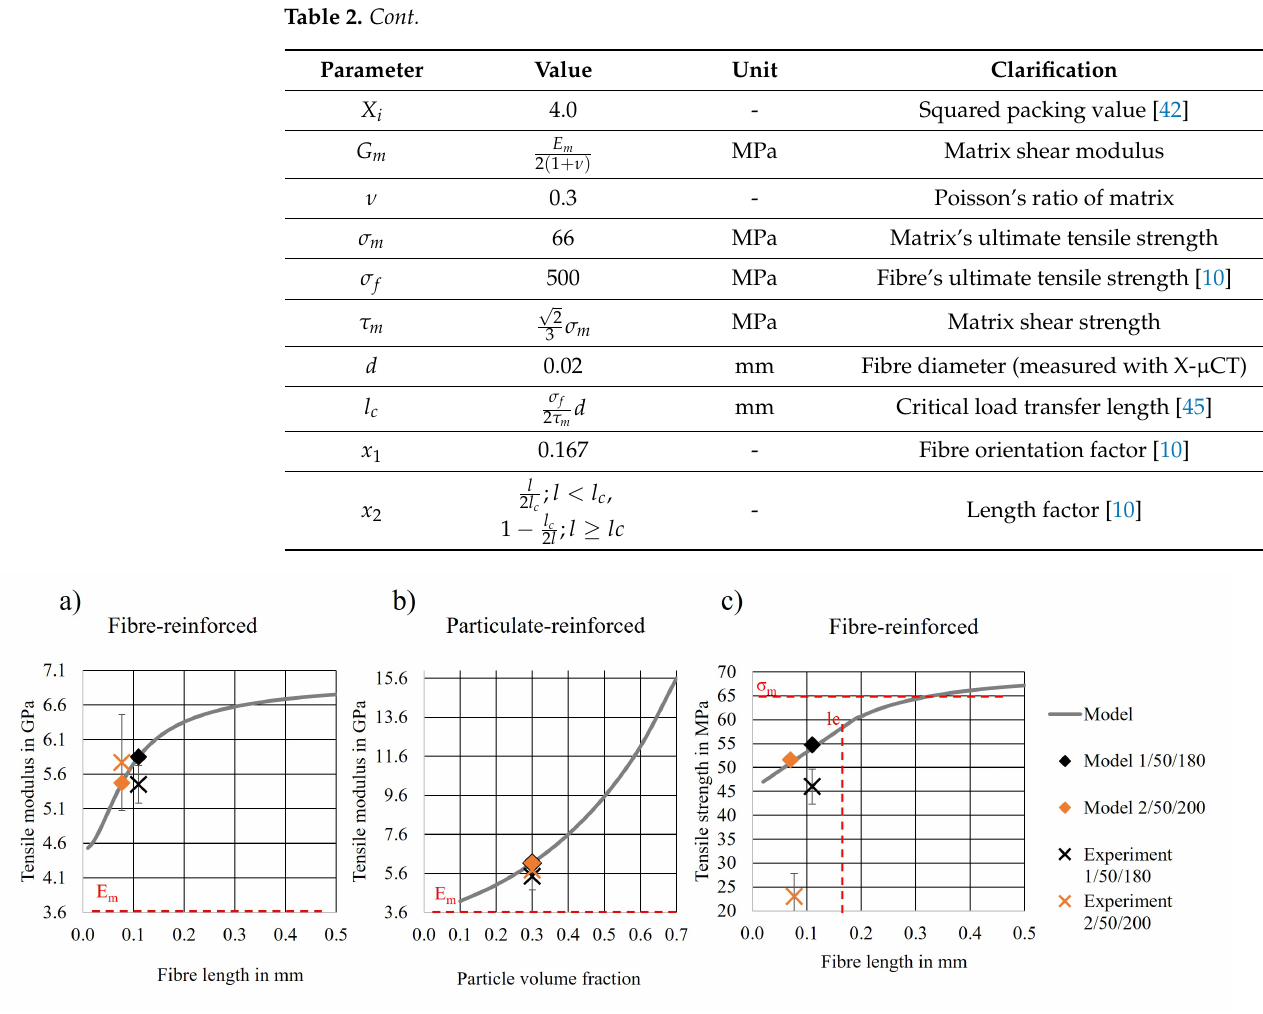
Figure 3. Micromechanical models for ( a ) Tensile modulus for short-fibre-reinforced composites (Cox) with varying fibre length, ( b ) tensile modulus for particulate-reinforced composites (Mital) with varying particle volume fraction and ( c ) tensile strength of short-fibre-reinforced composites (Bowyer and Bader) with varying fibre